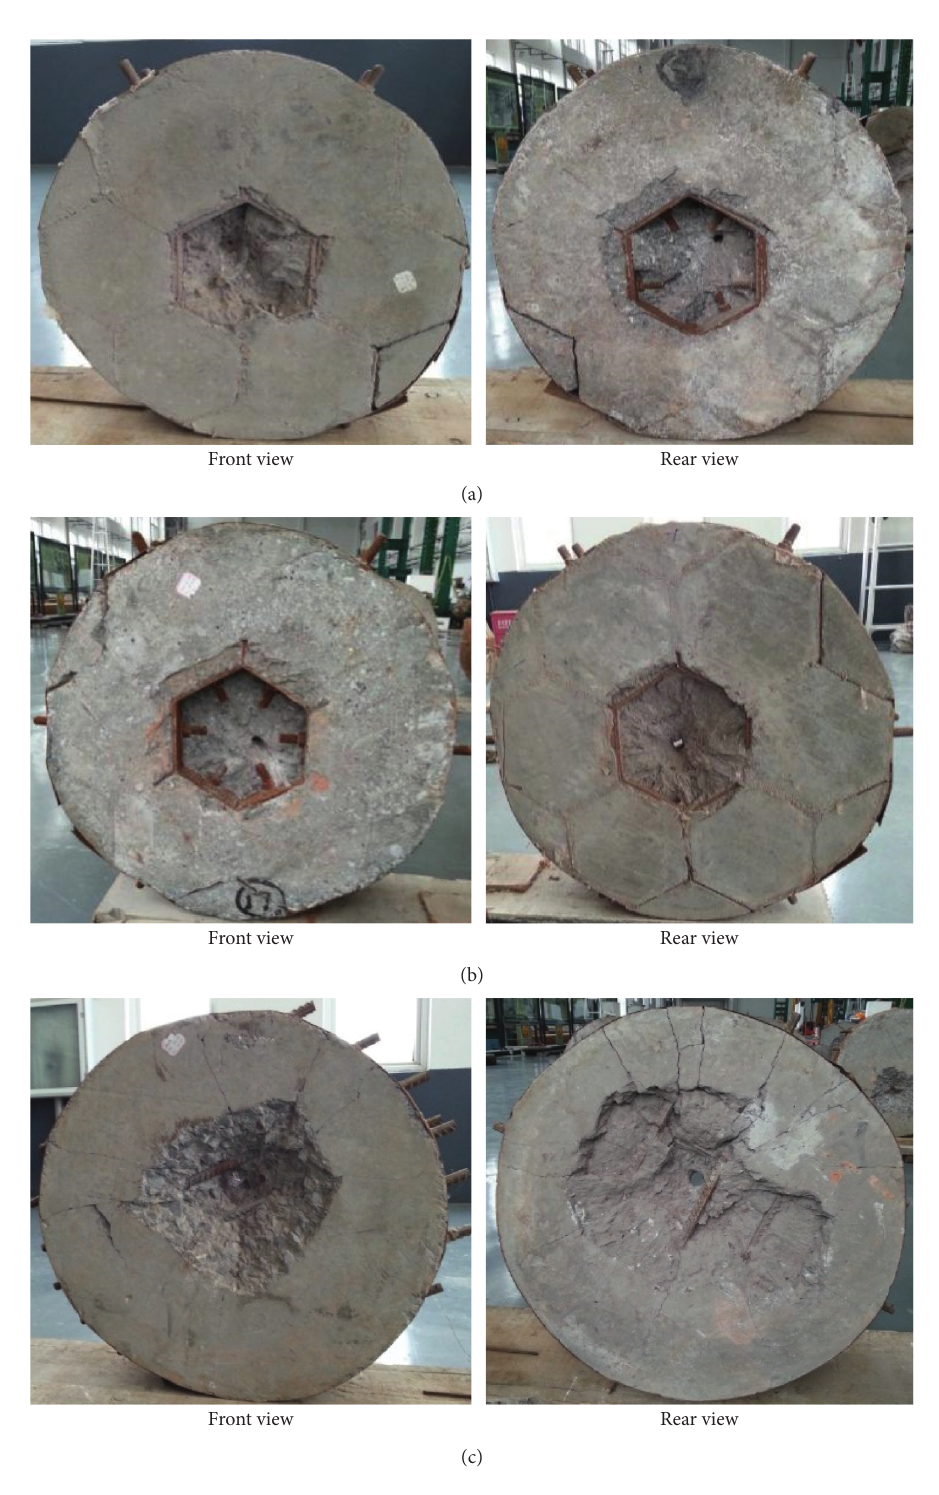
Figure 7: Target after test: (a) HST1 front view and rear view, (b) HST2 front view and rear view, and (c) RCT1 front view and rear